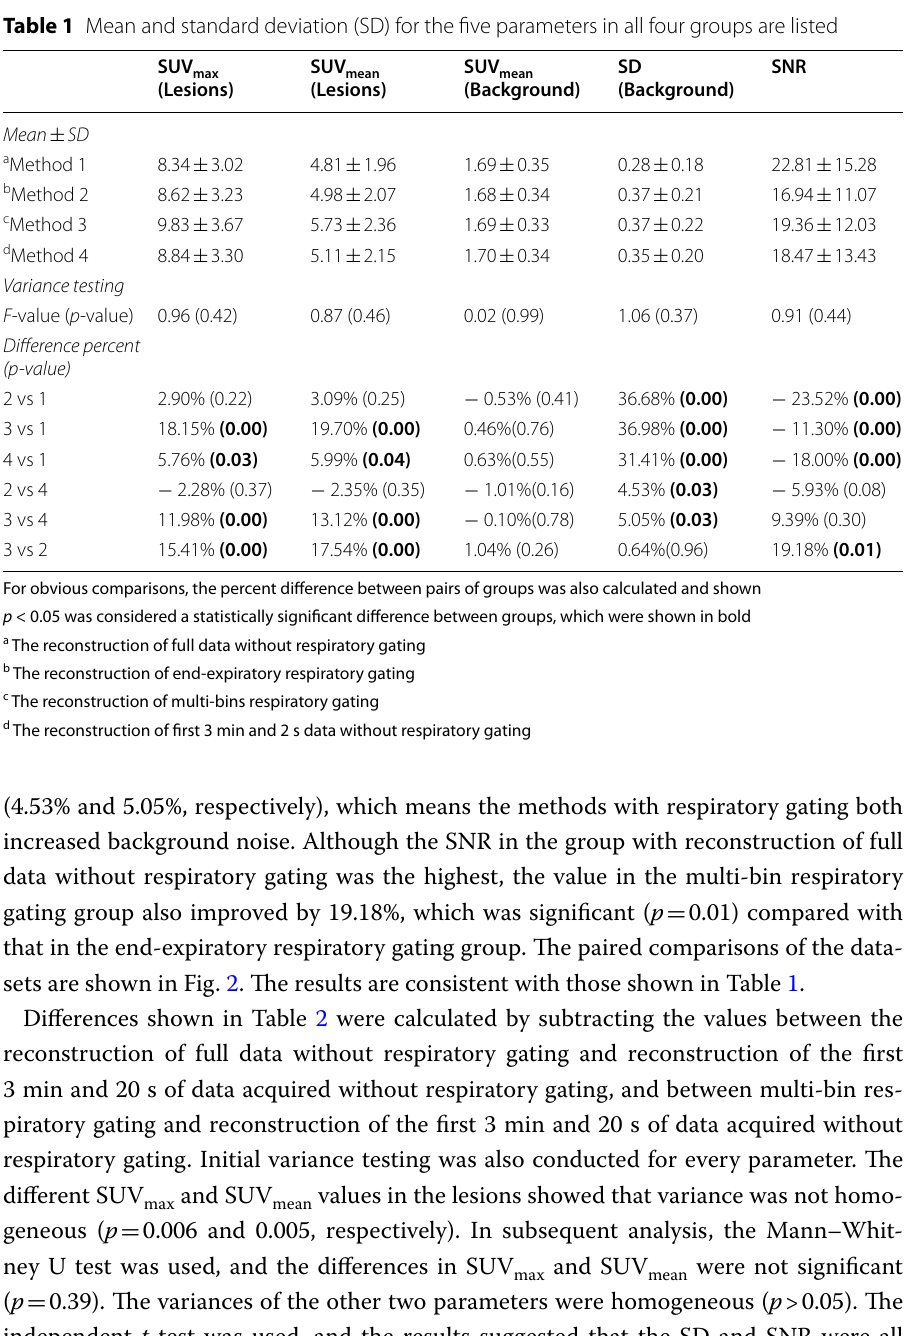
Table 1 Mean and standard deviation (SD) for the five parameters in all four groups are listed